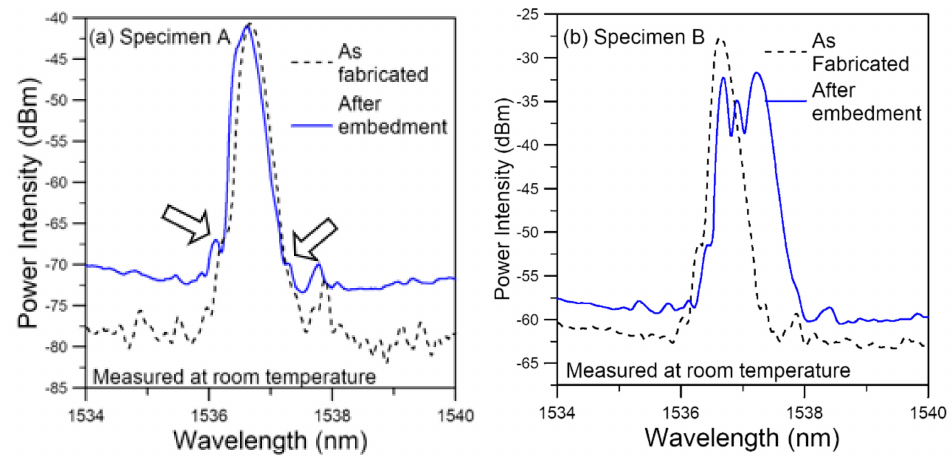
Figure 3. Typical FBG spectrum changes after joint curing: ( a ) a slight shift and an emergence of secondary peaks (pointed out by arrows); ( b ) peak splitting and spectrum broadening.